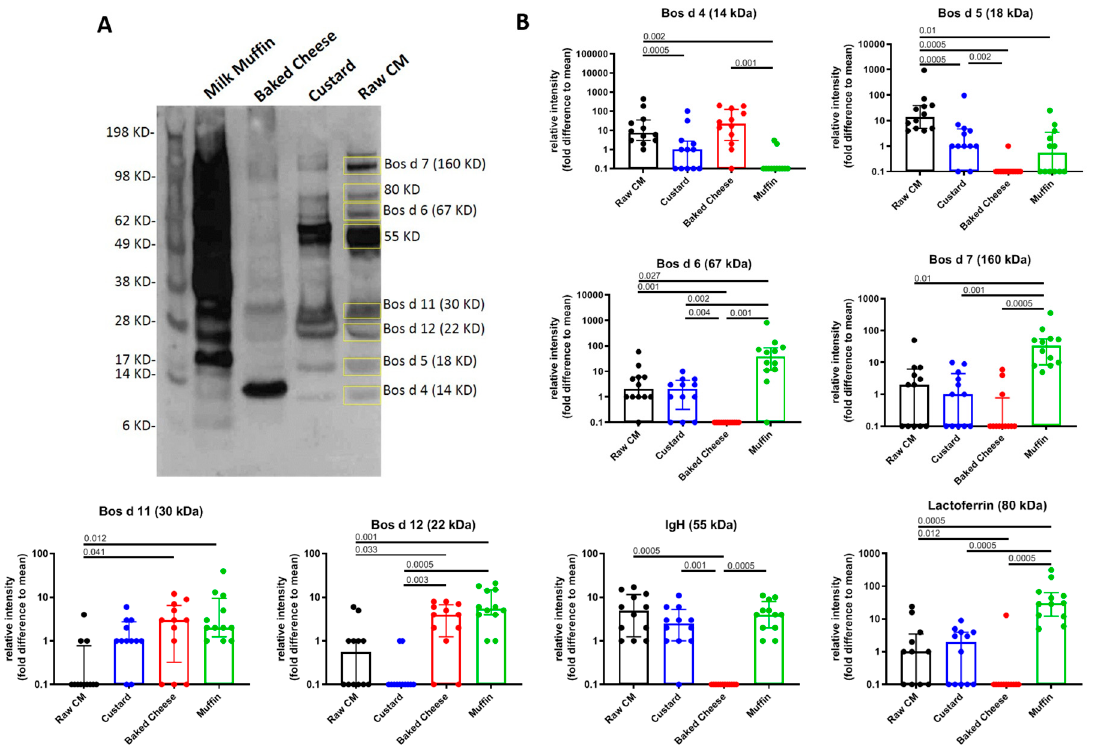
Figure 3. Quantification of IgE reactivity of allergen-corresponding protein bands in raw, pasteurized CM, custard, baked cheese and muffin extracts. ( A ) Representative western blot using an individual plasma sample, showing IgE-reactive protein bands. Bands that were quantified are shown in the raw, pasteurized CM extract lane, indicated by yellow boxes. Molecular weight markers (KD) are shown in the left side. ( B ) Bar graphs showing quantification of the eight protein bands (relative band intensities expressed as fold difference to mean) in the four extracts from western blots of individual subjects. Bars represent median, with error bars showing interquartile range, (n = 12).